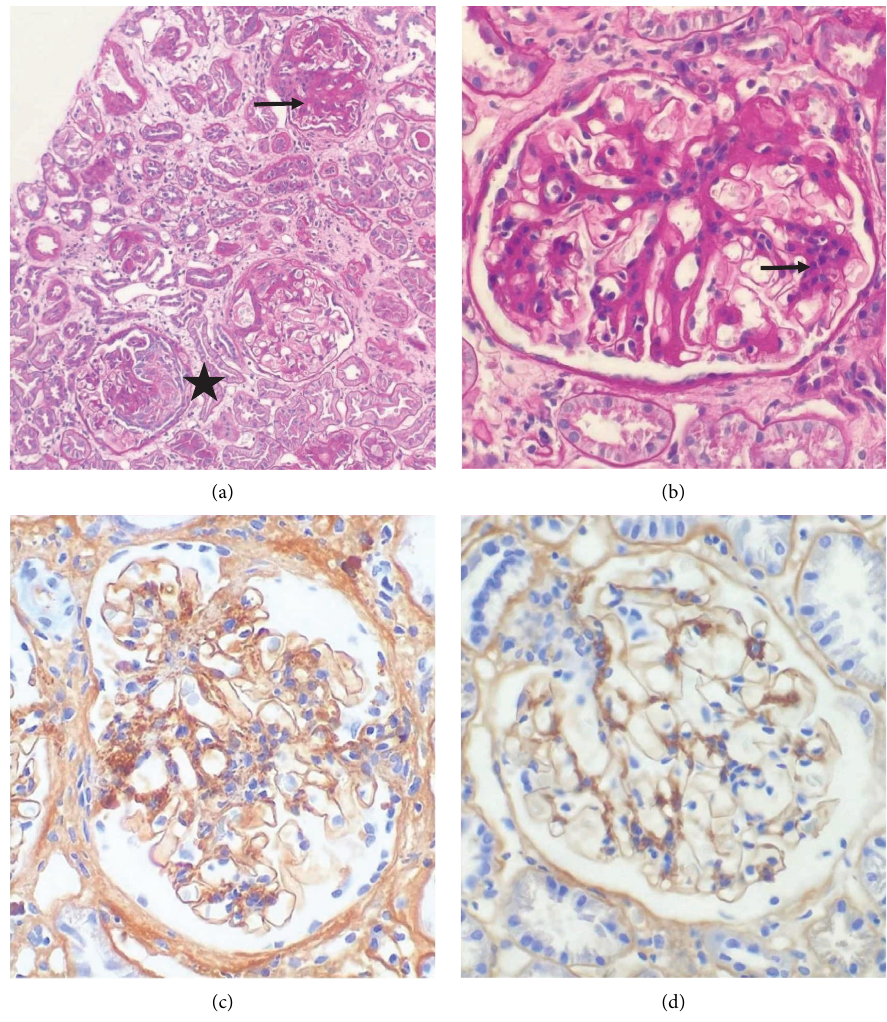
Figure 2: (a) Periodic acid-Schif stained parafn sections showing mesangial hypercellularity (arrow) and a focal cellular crescent (star) (x 100). (b) Higher magnifcation of glomerulus exhibiting mesangial hypercellularity (arrow) (x 400). (C) and (D) Immunohistochemical staining for IgA–strong mesangial and focal paramesangial staining, early subendothelial deposits are also appreciated (C). Strong mesangial staining was noted in occasional glomeruli which did not exhibit mesangial hypercellularity